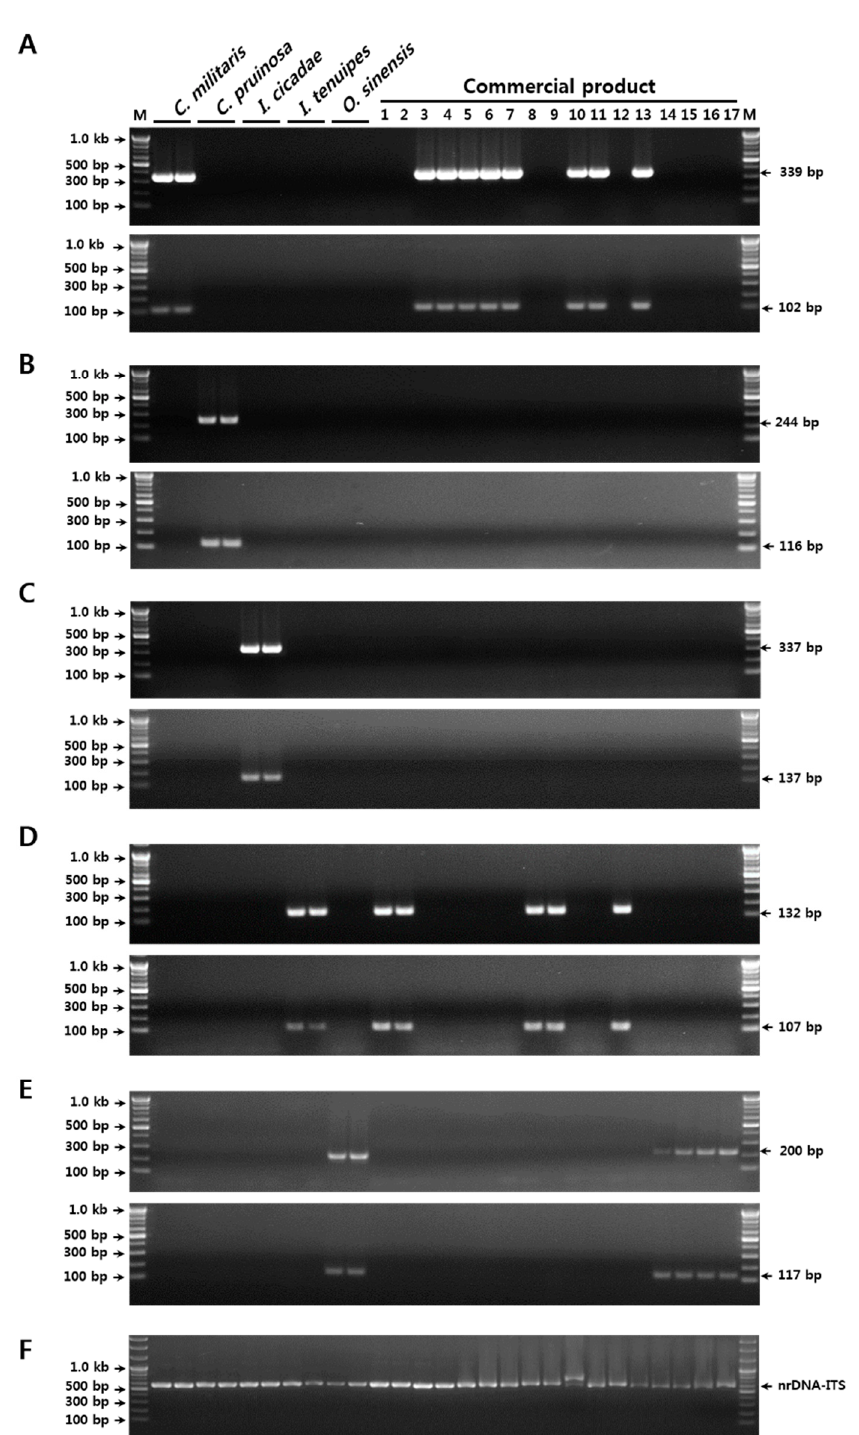
Figure 3. Validation of SCAR marker discriminability, and authentication of the taxonomic origin of resources in commercial Cordyceps and its related products. ( A ) Outcome of PCR amplification with the C. militaris -specific SCAR markers. ( B ) Outcome of PCR amplification with the C. pruinosa -specific SCAR markers. ( C ) Outcome of PCR amplification with the I. cicadae -specific SCAR markers. ( D ) Outcome of PCR amplification with the I. tenuipes -specific SCAR markers. ( E ) Outcome of PCR amplification with the O. sinensis -specific SCAR markers. ( F ) Outcome of PCR amplification with the nrDNA-ITS primers (ITS1 and ITS4) as control. Numbers 1–17 in the commercial products correspond to those listed in Table 5. The precise lengths of the PCR products and the DNA ladders are indicated to the right and left of the gel images, respectively. M, 100 bp DNA ladder.